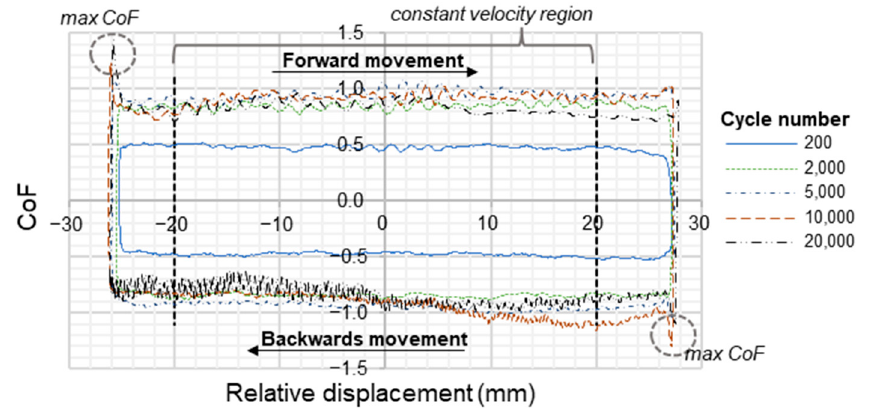
Figure 13. Coefficient of friction resoved over displacement at different cycle numbers for normal pressure of 1 MPa and 100 mm/s for dry friction.